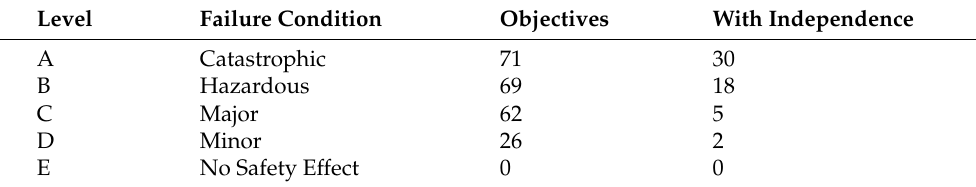
Table 2. DO-178C development assurance